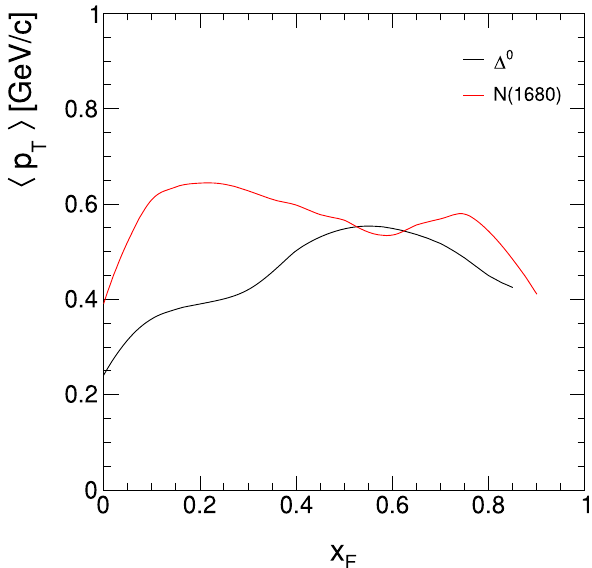
Fig. 193 Mean p T for π − from the decay of baryonic resonances as a function of x F